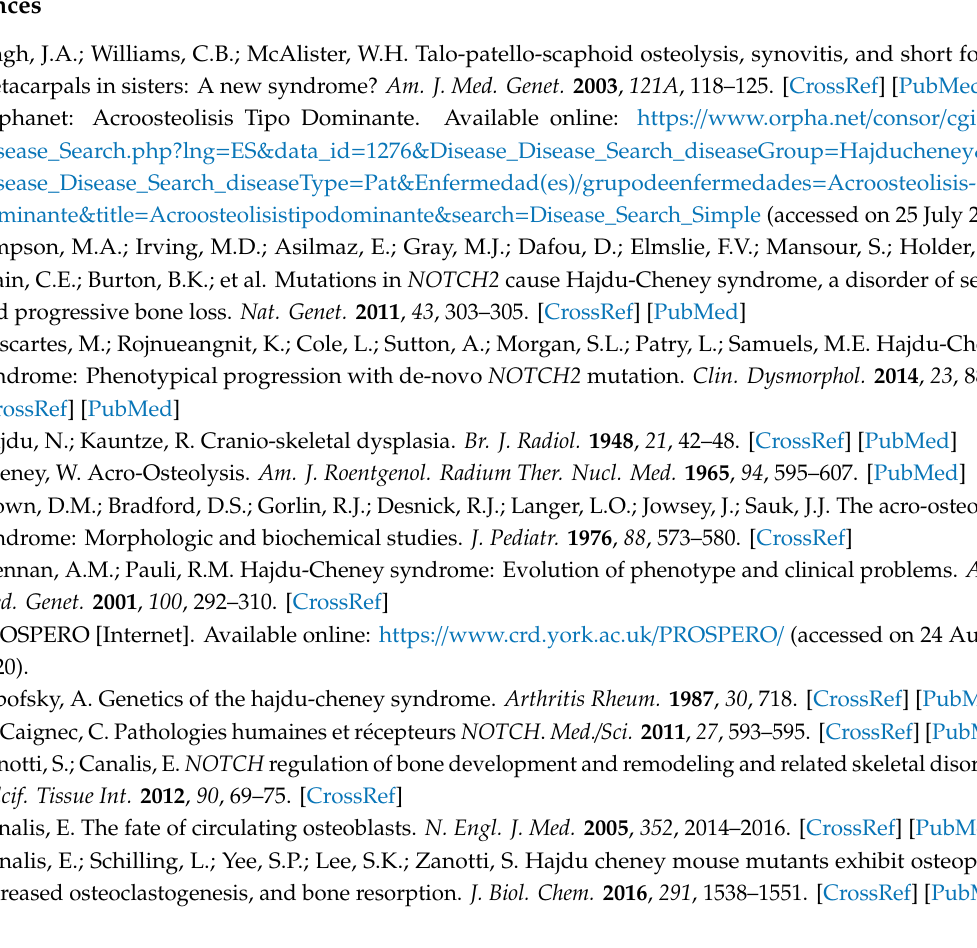
Table S1: Objectives, results, sample and demographic region shown for all 76